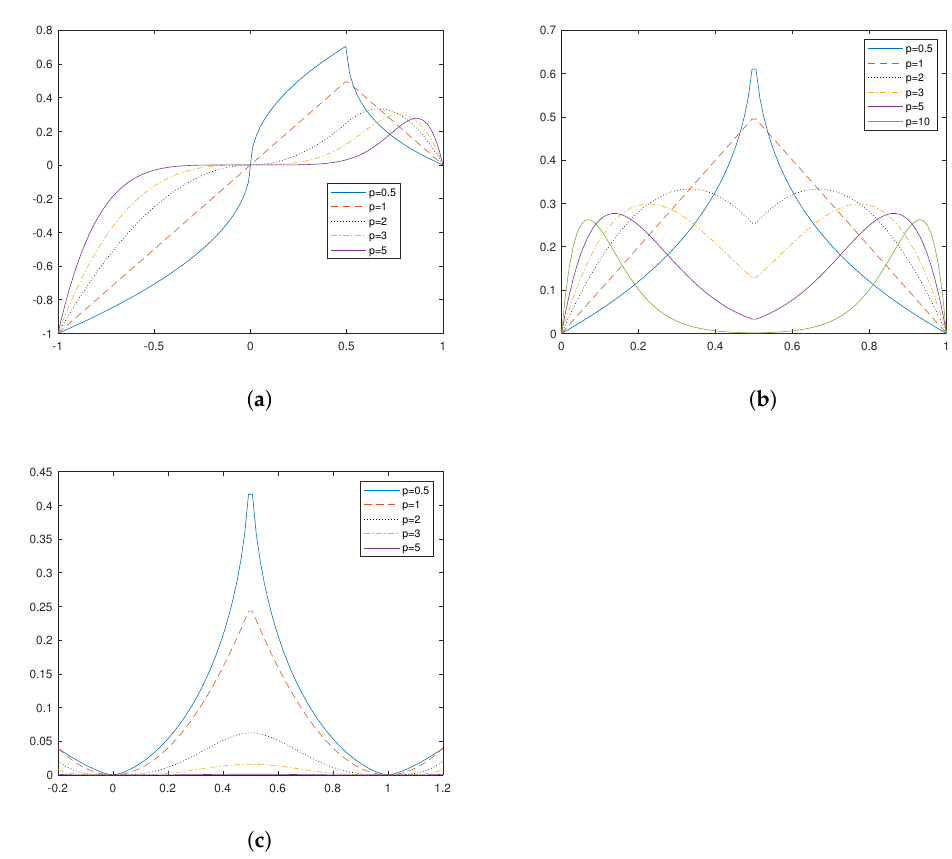
( x ) , (cid:101) τ p ( x ) and (cid:101) σ p ( x ) with different values of p . ( a ) Local maximum of NR S − NR S − NR ( x ) ; ( c ) Local minimum and maximum of (cid:101) σ p S − NR ( · ) is simple. fi , gi